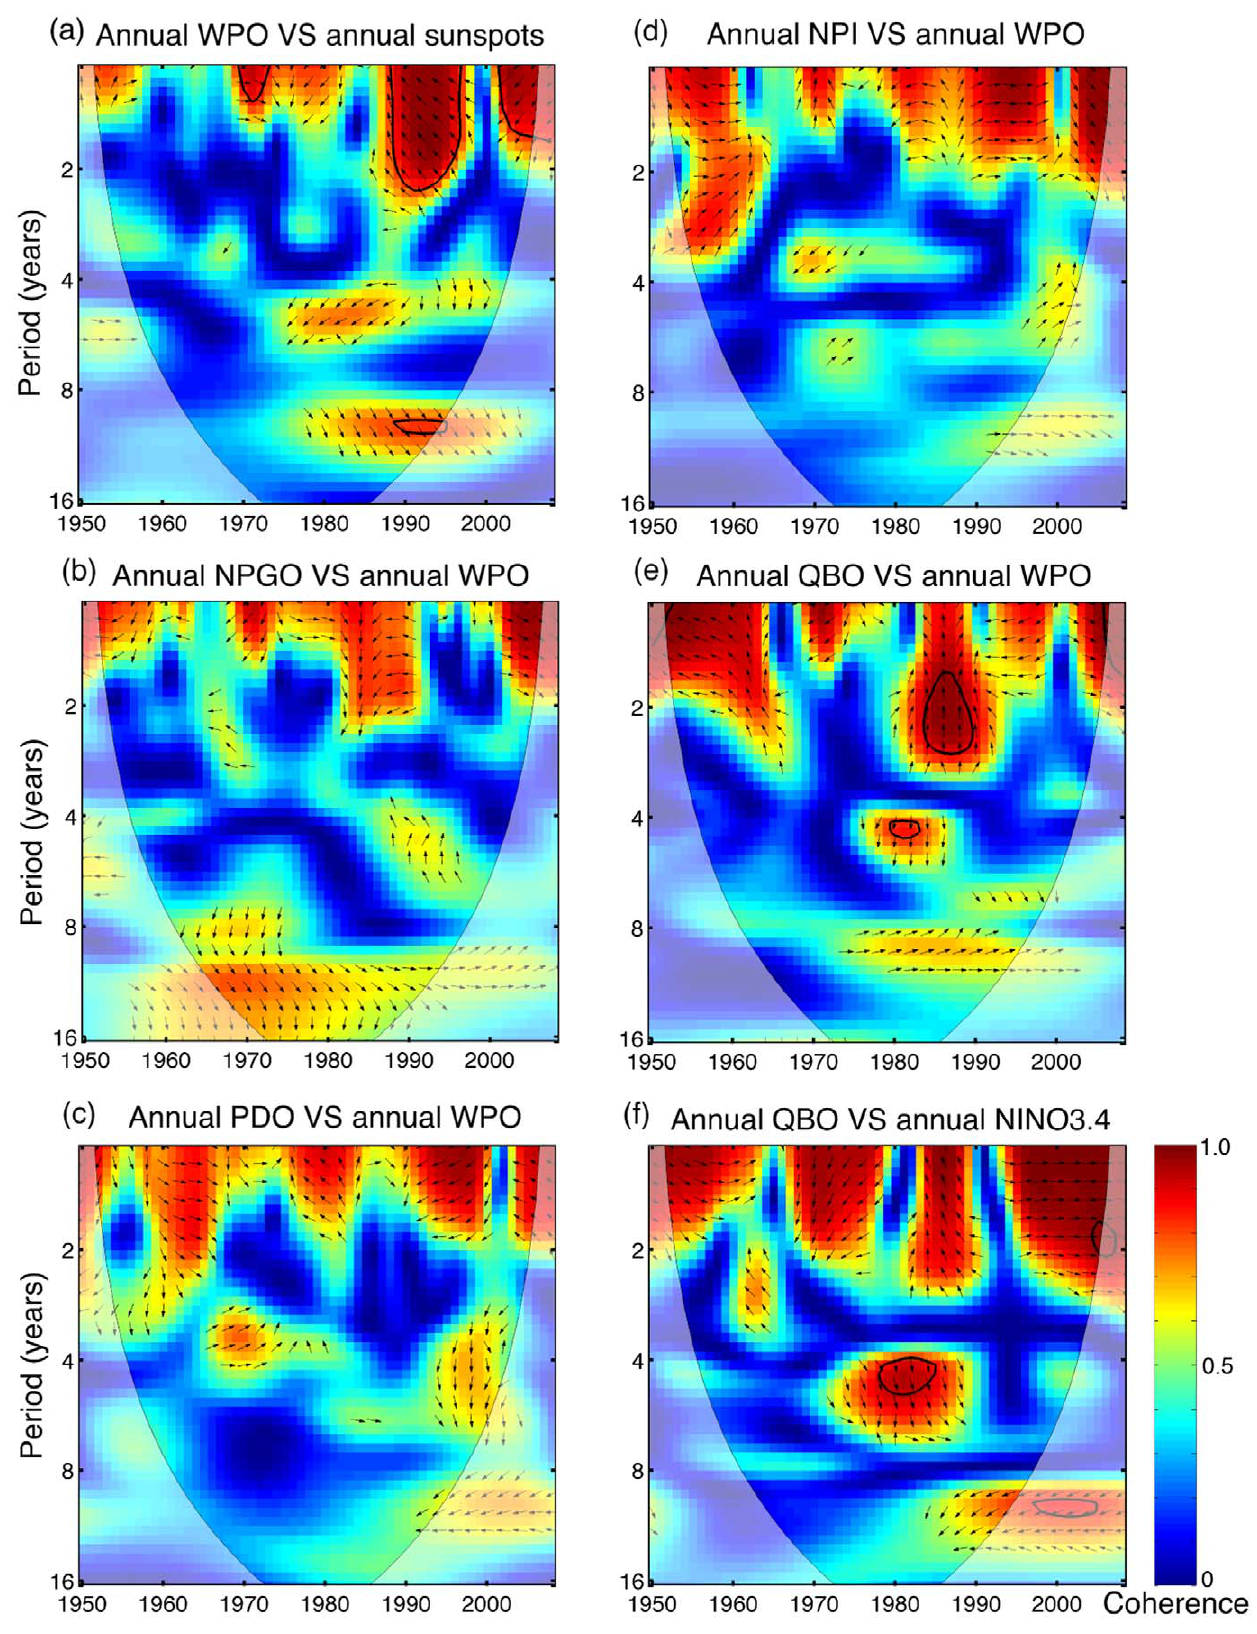
Figure 5. Cross wavelet coherence between climate indexes: (a) WPO versus sunspot numbers, (b) NPGO versus WPO, (c) PDO versus WPO, (d) NPI versus WPO, (e) QBO versus WPO, and (f) QBO versus Nin ˜ o3.4. See Figure 4 for legends. doi:10.1371/journal.pone.0030805.g005 PLoS ONE |